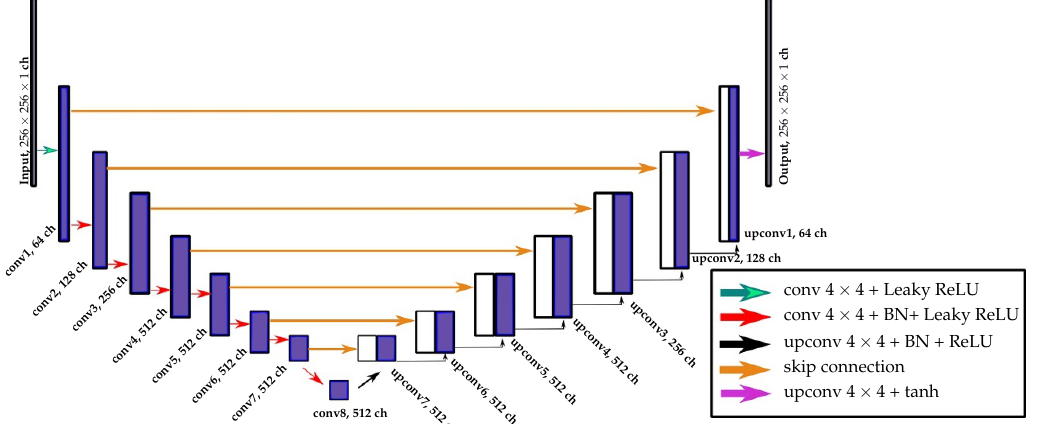
Figure 1. Schematic overview of the UNet architecture used adapted from Bittner et al. [43]. Each convolution operation has a kernel of size 4 4 with stride 2. For up-sampling, the transposed × convolution operations with kernels of size 4 4 and stride 2 are used. The Leaky ReLU activation × function in the encoder part of the network has a negative slope of